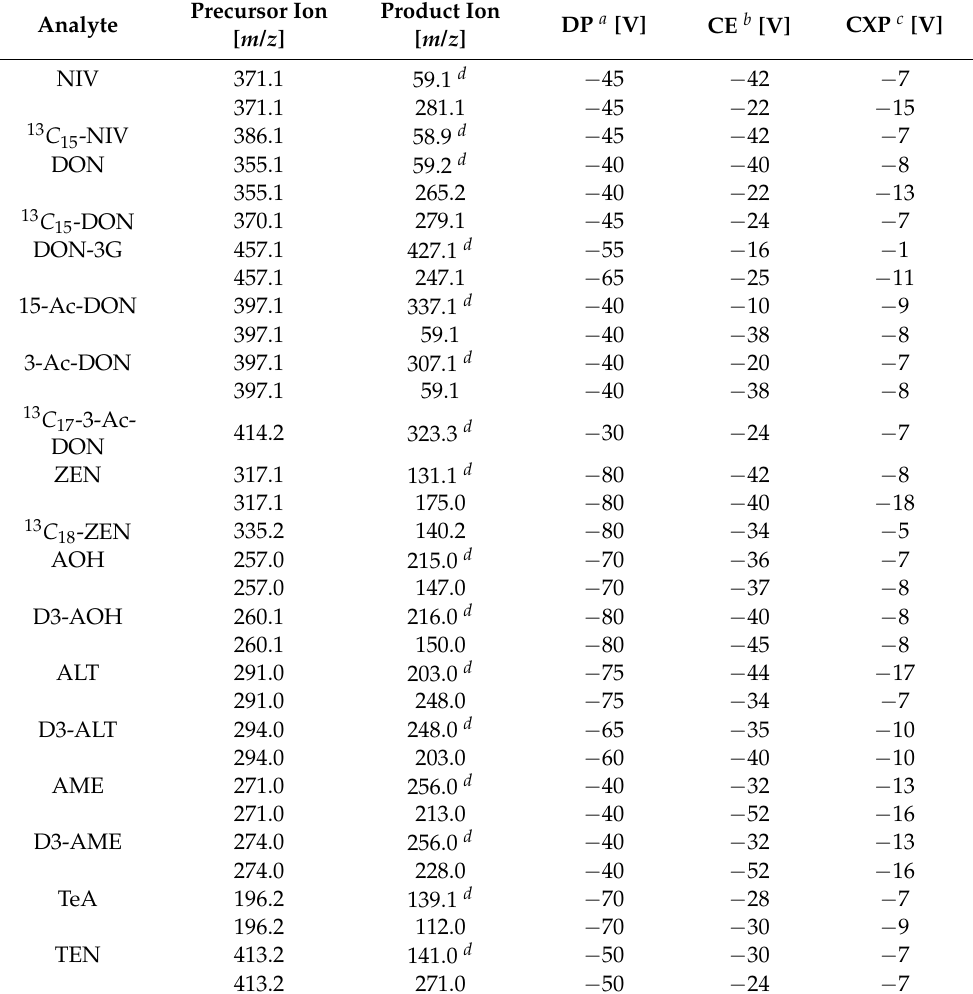
Table 3. Optimized MS/MS conditions for detection of the target mycotoxins. Precursor Ion Analyte